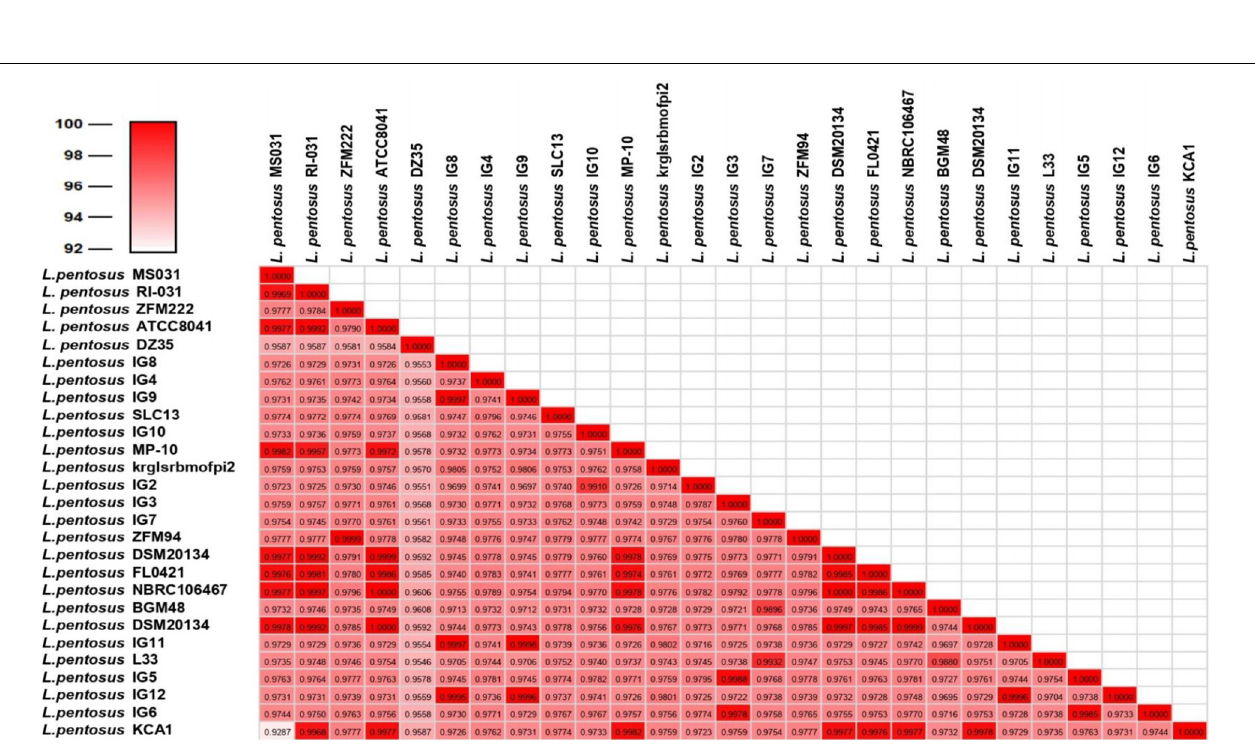
FIGURE 2 | Neighbor-joining phylogenetic tree of L. pentosus L33 and 26 L. pentosus strains based on orthologous genes found by Roary (version 3.13.0). Values of 1,000 bootstrap replicates calculated by MEGAX (version 10.1.8) are depicted.